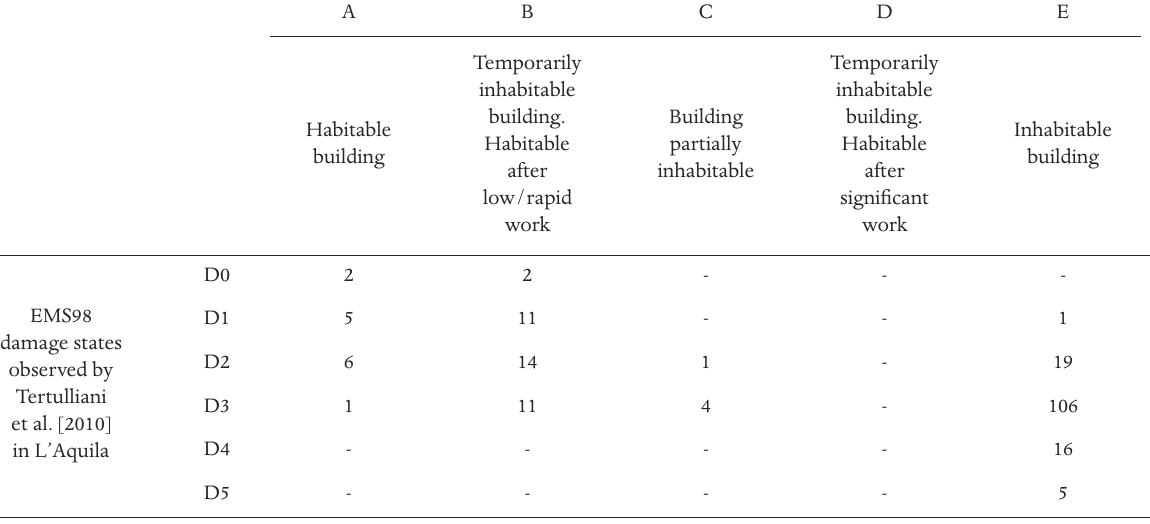
Table 6. Relation between EMS98 damage states observed by Tertulliani et al. [2010] and its AeDES habitability state [Comune di L’Aquila 2014] for 204 buildings. Note: There is a sixth habitability class ‘F’ meaning ‘Inhabitable building caused by neighboring buildings/elements’ but this is not present in the sample of buildings considered